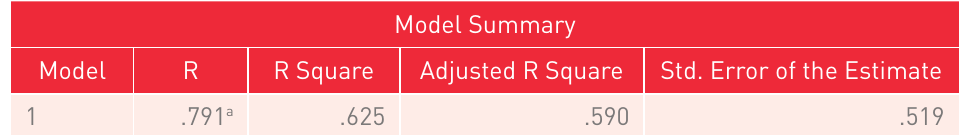
Overall model fit